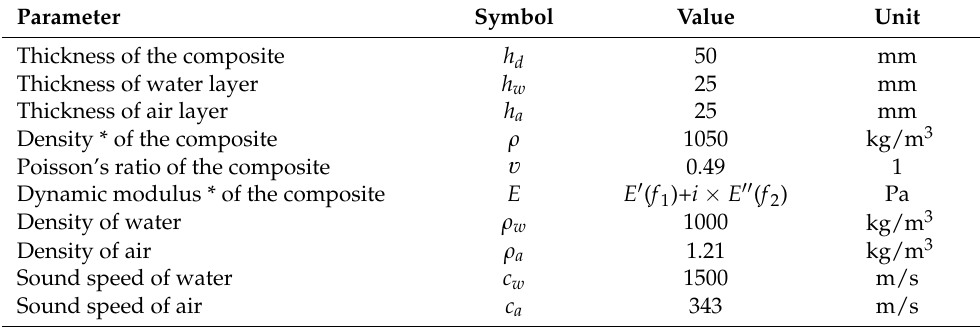
Table 1. Material and geometric parameters of the model. Parameter